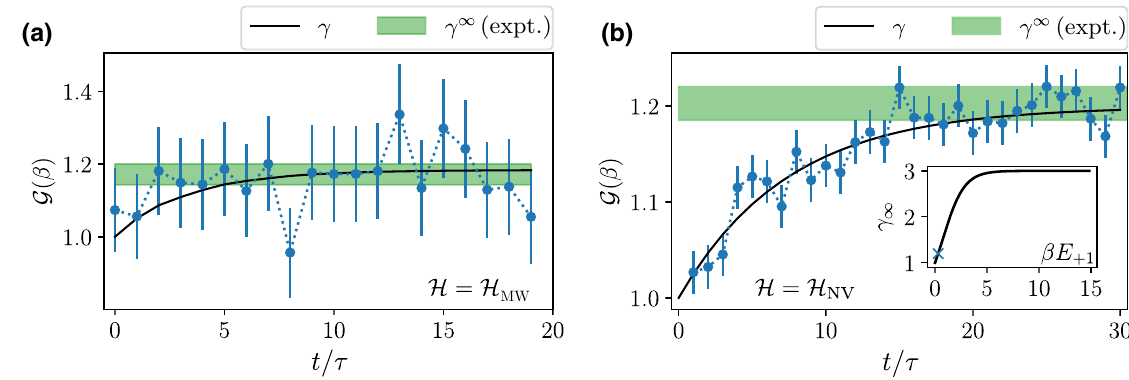
FIG. 3. Experimental verification of the generalized quantum Sagawa-Ueda-Tasaki relation (13) for a 3LS controlled by an autonomous dissipative Maxwell’s demon. The energy variation statistics are shown in terms of the total time of the experiment divided by the time between laser pulses (i.e., in terms of the number of laser pulses N L = t /τ ). (a) The continuous coherent driving of the 3LS is defined by the Hamiltonian H MW , and the value of the inverse temperature of the initial state is given by β = 3 / E + ω . (b) Same as (a) but for a Hamiltonian H NV , and an inverse temperature of the initial state β = 0.297 / E + 1 . Blue circles represent the measured values of the characteristic function G (β) , the continuous black line denotes the theoretical estimation of γ [Eq. (15)], and the green area marks the experimental value of γ ∞ [Eq. (14)], the asymptotic value of γ . The inset shows the theoretical value of γ ∞ as a function of the initial inverse temperature β . The blue cross is associated with the value of β used for the experimental data in